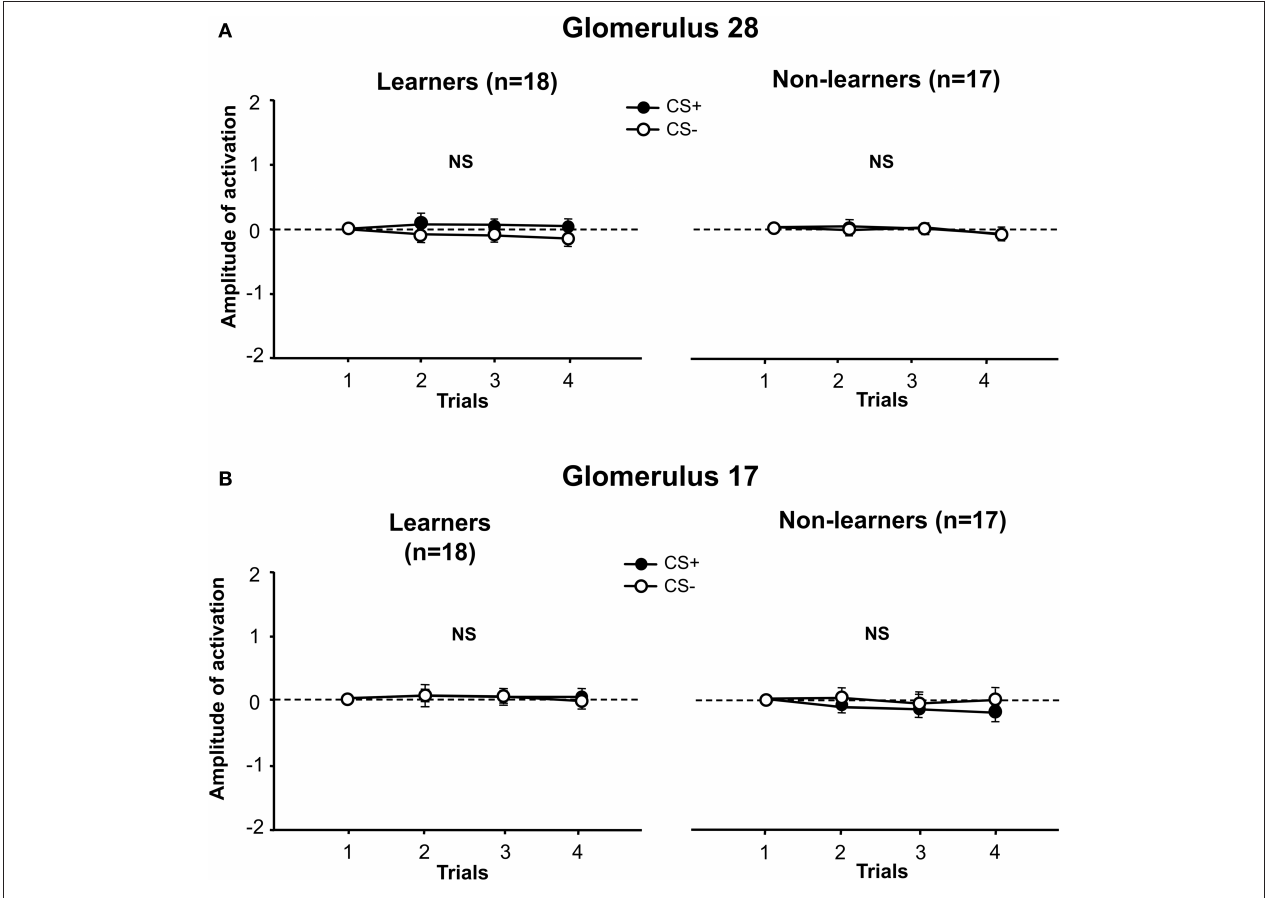
Figure 5 | Activation amplitude of individual glomeruli during conditioning. (A) For learners and non-learners, in glomerulus 28, the amplitude of activation did not change along conditioning trials and there was no difference between groups ( stimulus effect: p = NS,